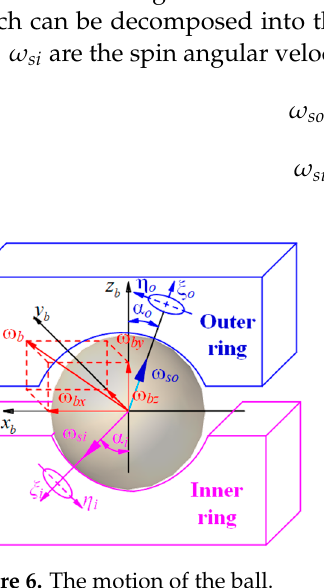
where SR o is the spin-roll ratio of the ball on the outer raceway; SR i is the spin-roll ratio of the ball on the inner raceway; and ω ro , ω ri are the rolling angular velocities of the ball on the outer ring and inner ring, respectively. When ball bearings are working at high speed, the forces acting on the j th ball are shown in Figures 7 and 8.